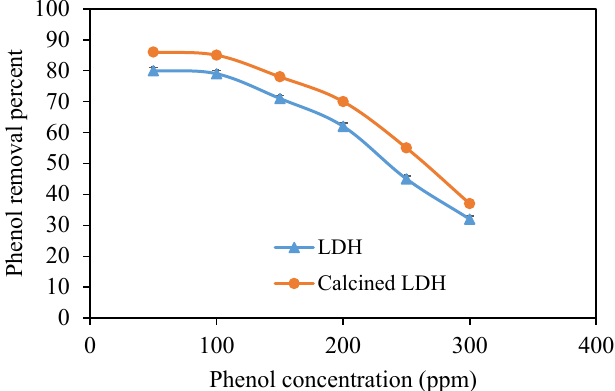
Fig.6. Effect of concentration of phenol on its removal percentage in CWPO process on Mg-Al LDH and calcined LDH (reaction con- ditions: V = 100 mL, m = 0.05 g, reaction time = 45 min, temperature = 60 ºC).